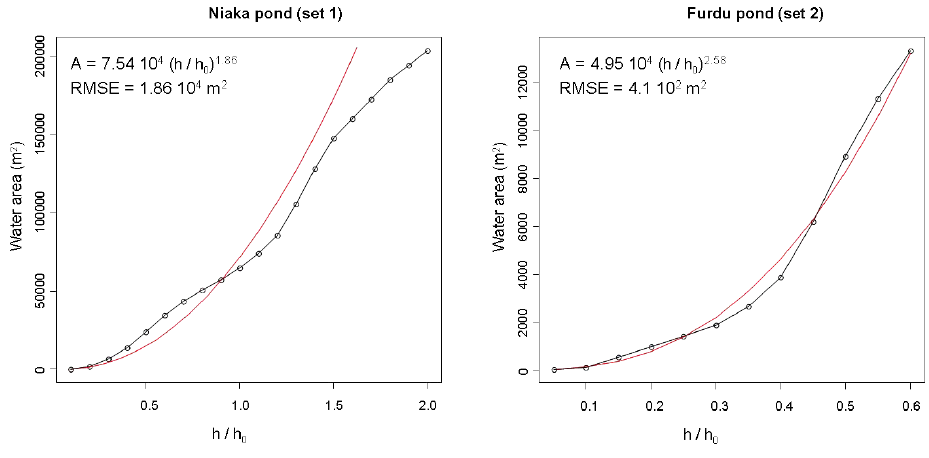
Fig. 3. Water area and water height relations for Niaka and Furdu ponds, Barkedji area, Ferlo region, Senegal.